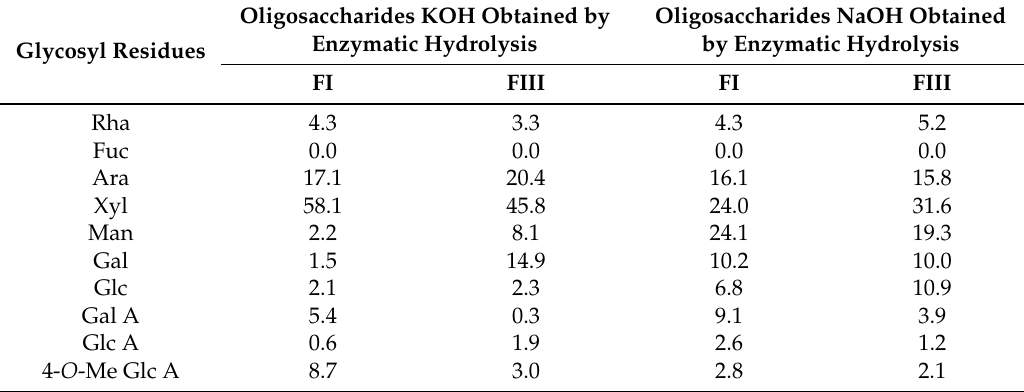
Table 4. Monosaccharide composition determined by GLC of oligosaccharides fractions derived from the hemicellulosic fractions by hydrolysis with endo-xylanase.